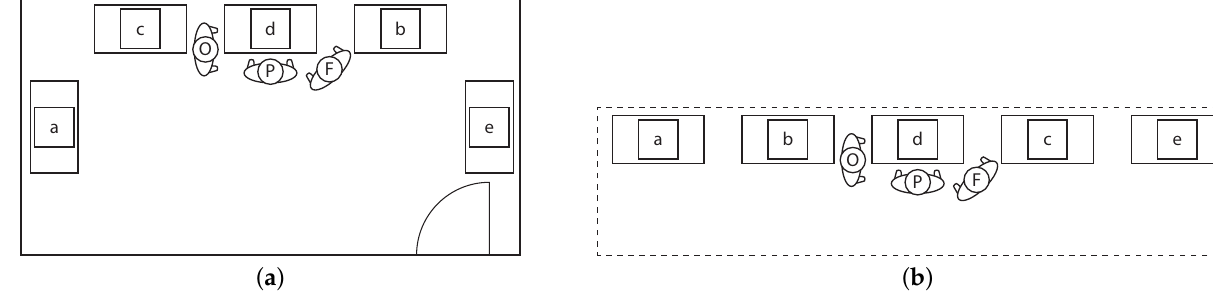
Figure 4. Usability study setup (P = Participant; F = Facilitator; O = Observer) ( a ) Accessible gallery setup; ( b ) School for blind and visually impaired people